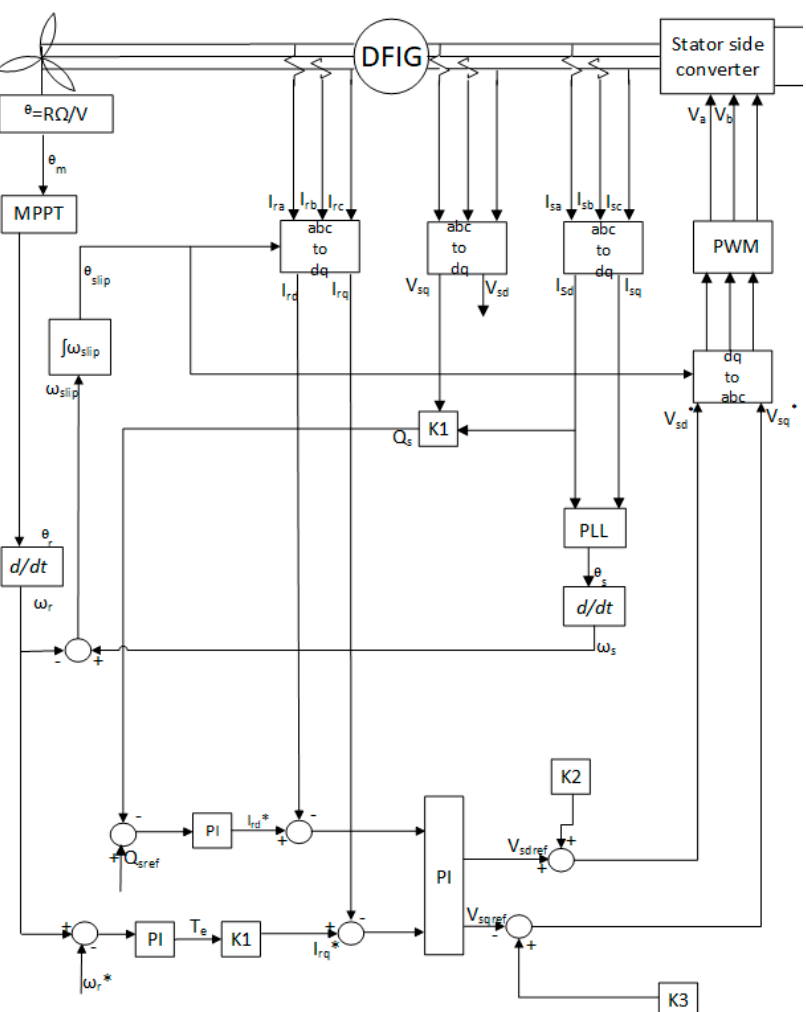
Figure 4. Control of the machine side converter of the DFIG which includes maximum power point tracking (MPPT), phase locked loop (PLL) and Proportional integral (PI) controllers.